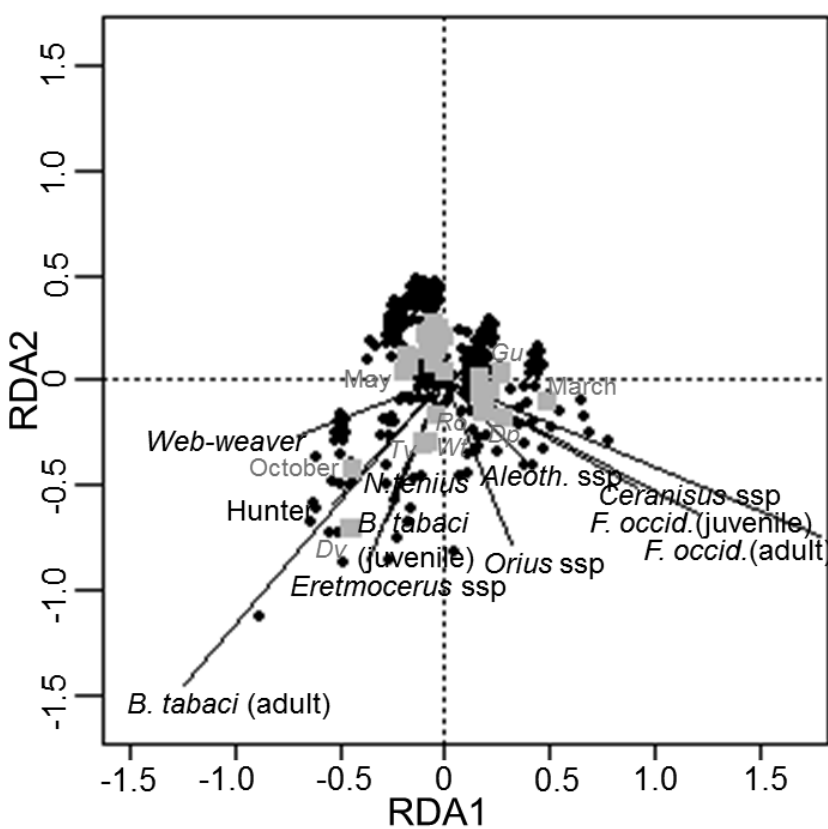
Figure 2. Redundancy Analysis (RDA) ordination diagram showing the variation in the abundance of the spider guilds, the pests Bemisia tabaci and Frankliniella occidentalis and their NEs ( ― ) with respect to two nominal variables: native plants and sampling period in months ( ■ ). Native plants are labelled using plant code from Table 1.